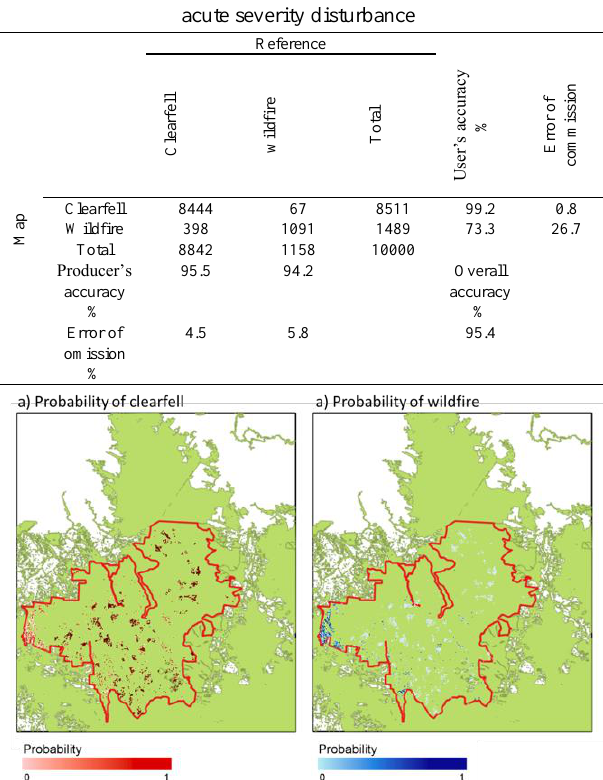
Table 3: Confusion matrix for predicting disturbance agents in acute severity disturbance